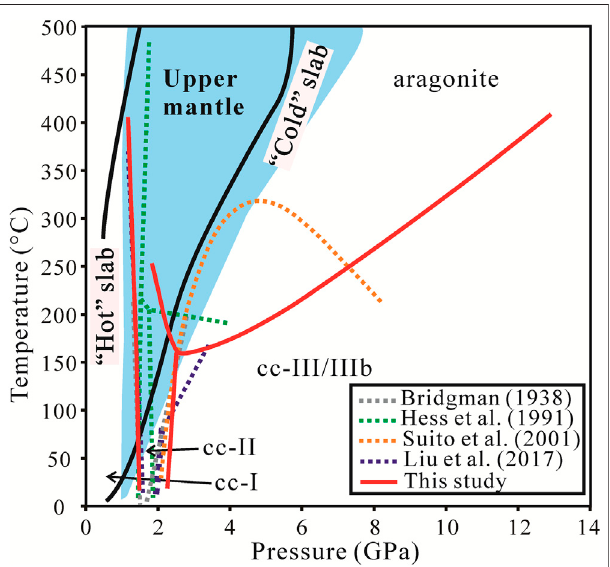
FIGURE 4 | Comparison of phase boundaries in different studies, with upper mantle and subducting plate conditions. The upper mantle is from Pan andGalli.(2016).ThecoldplateandthehotplatearefromW1300inSyracuse et al. (2010). At low pressures the deviations between our boundaries and previous works are relatively small, but at high P-T the boundaries are completely different.